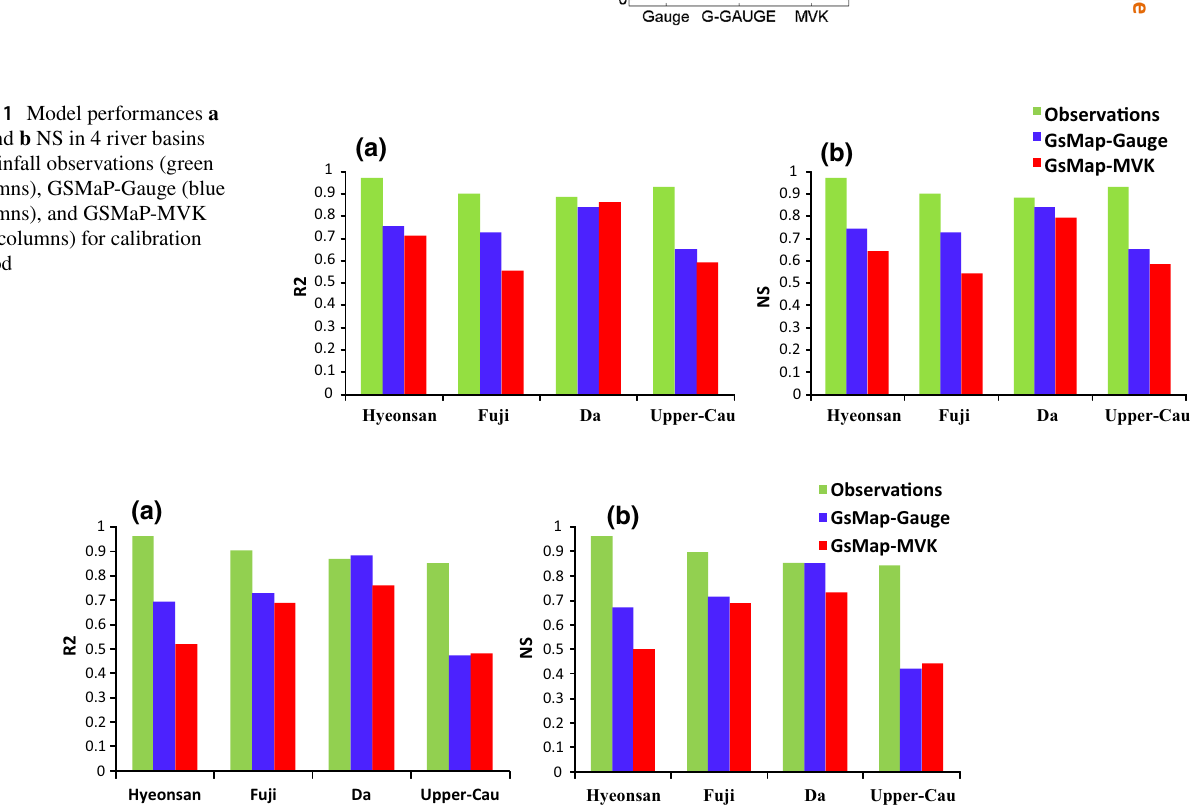
Fig. 12 Model performances R 2 and NS in 4 river basins of rainfall observations (green columns), GSMaP-Gauge (blue columns), and GSMaP- MVK (red columns) for validation